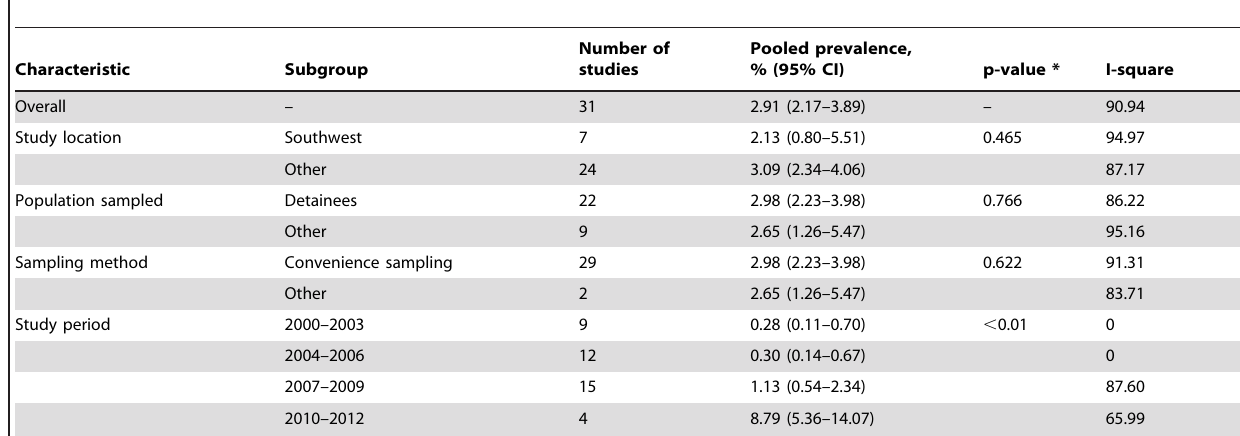
Table 3. Subgroup analyses for syphilis prevalence among male clients of female sex workers in